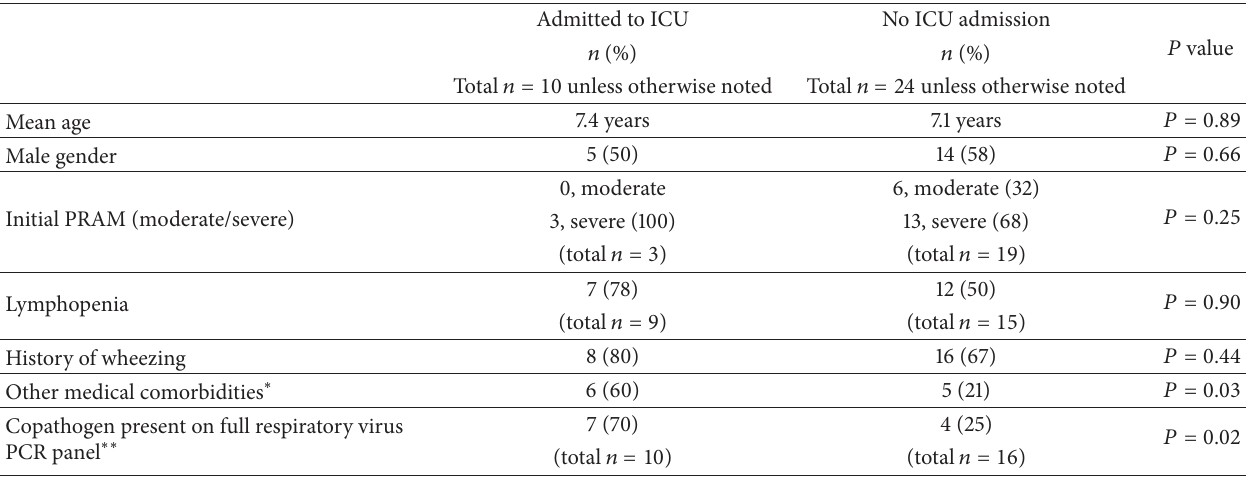
Table 4: Characteristics of children admitted to the PICU compared to children who did not require PICU